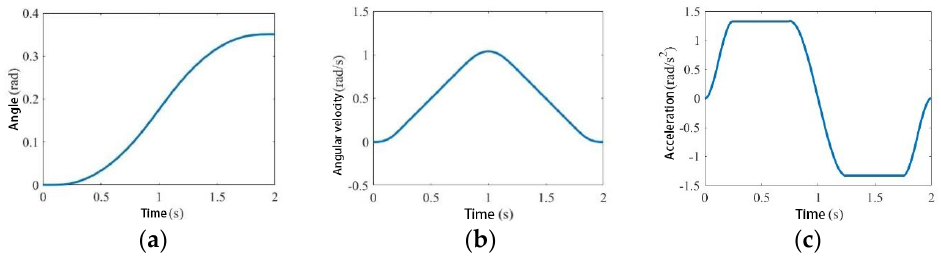
Figure 15. Angle, angular velocity and angular acceleration of joint 2.